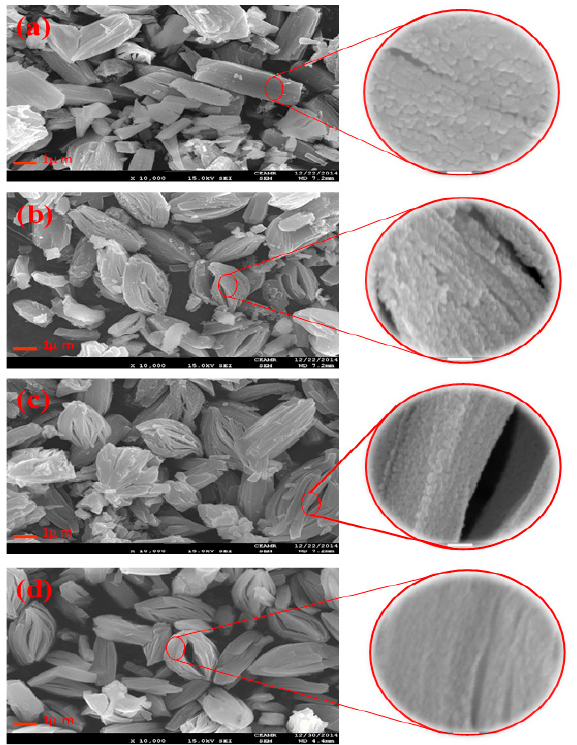
Figure 4. FE ‐ SEM images of the calcined NiO. ( a ); Gd/NiO ( b ); La/NiO ( c ); and Sm/NiO ( d ).